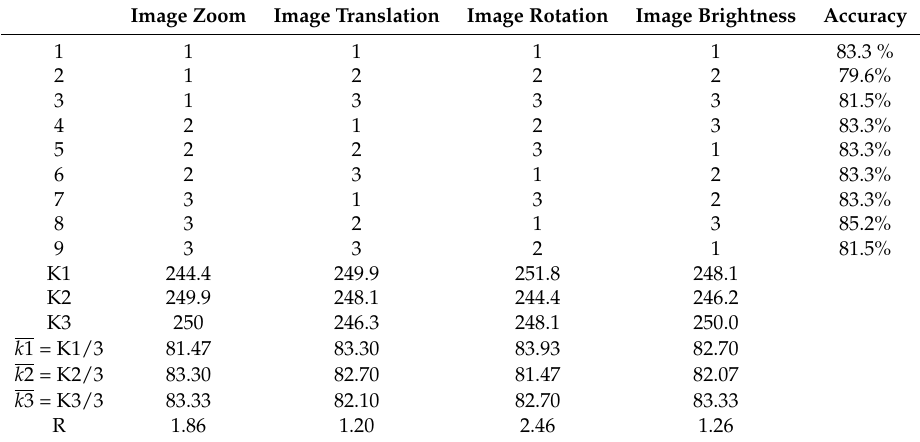
Table 2. The orthogonal experiment of geometric transformation and image brightness.